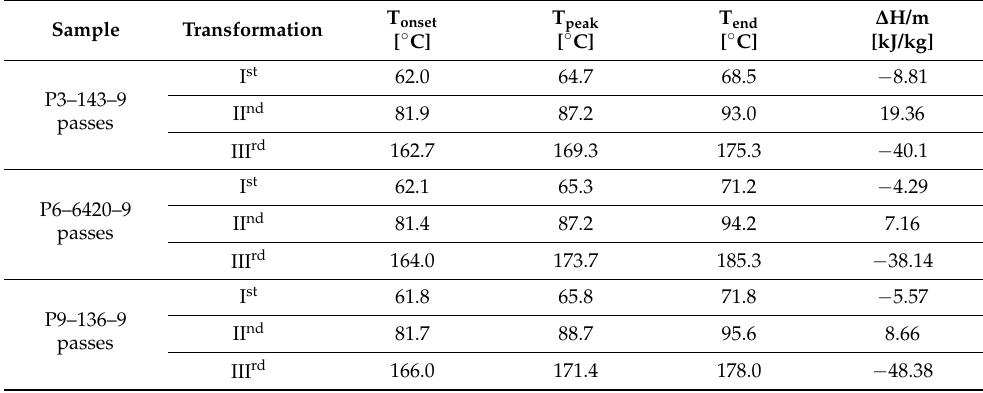
Table 3. Calorimetric characterization of samples coated with ceramic